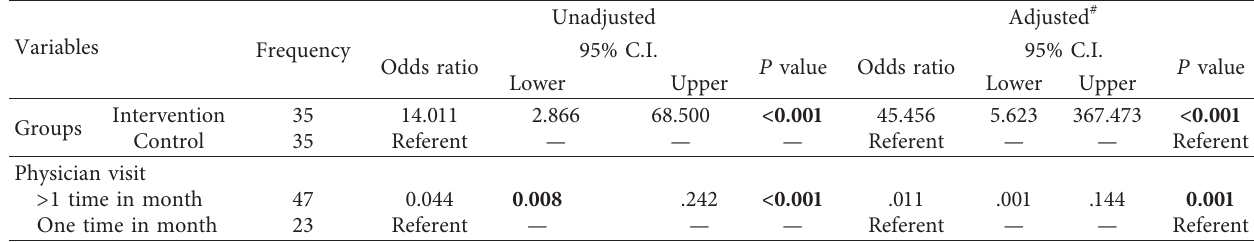
Table 3: Measurements of physician visit in intervention and control